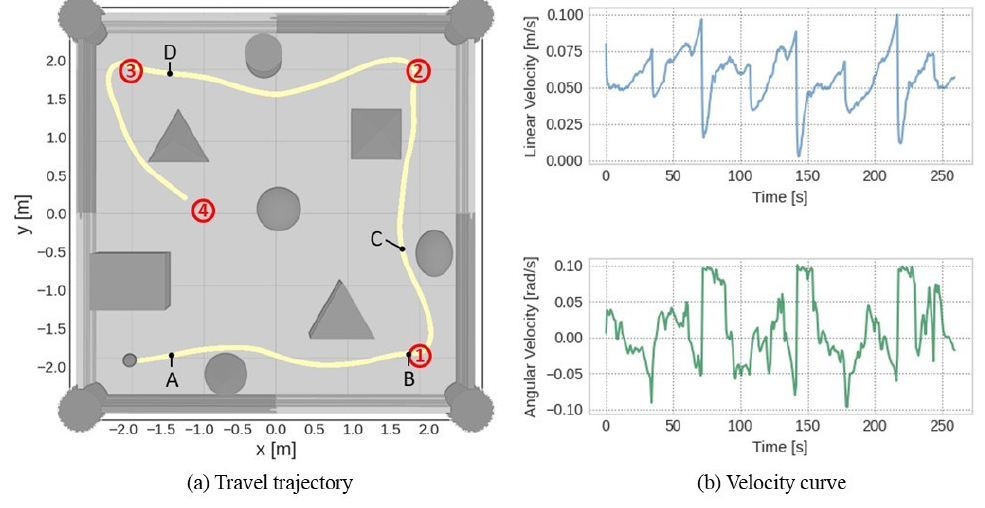
Figure 10. Travel trajectory and velocity